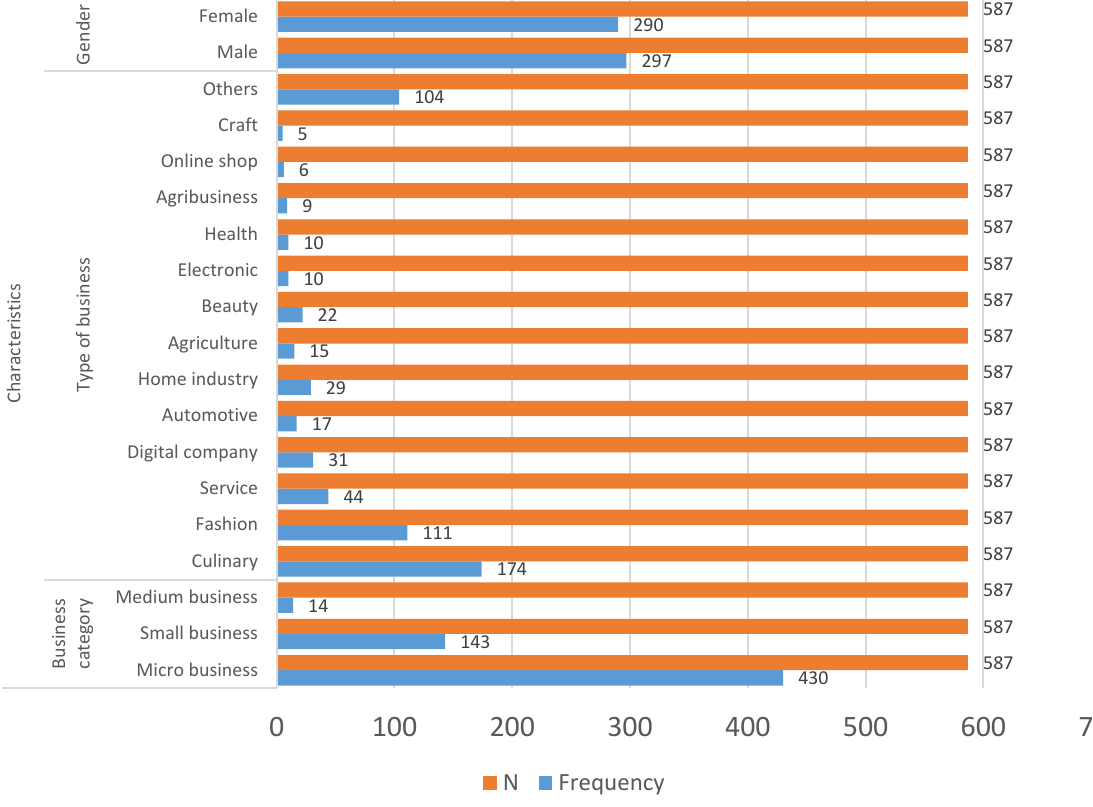
Figure 2. Characteristics of